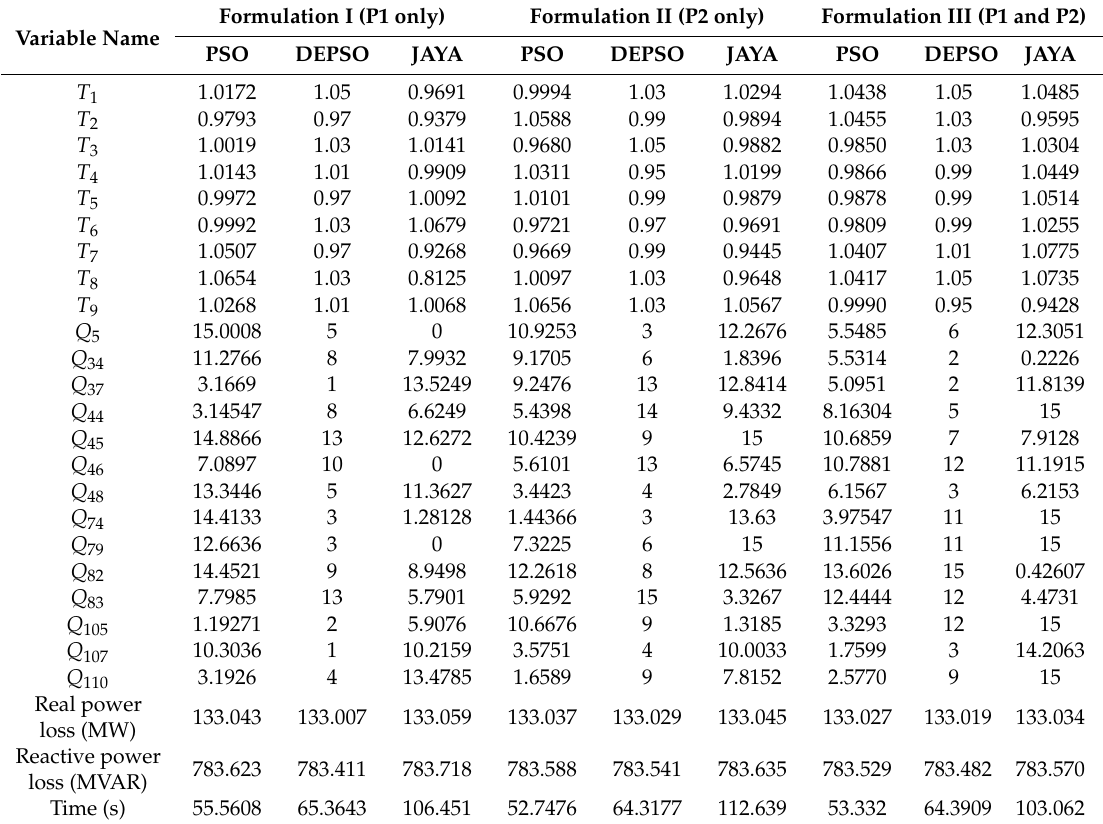
Table5. Optimalcontrolvariables(discreteandintegeronly)forIEEE118-bususingdi ff erentalgorithms.